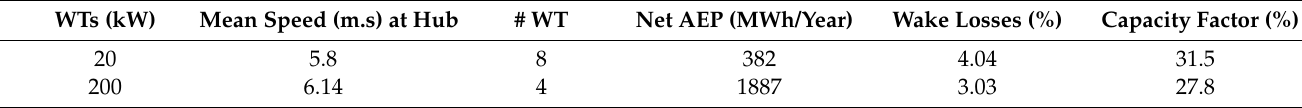
Table 10. Favignana wind technical